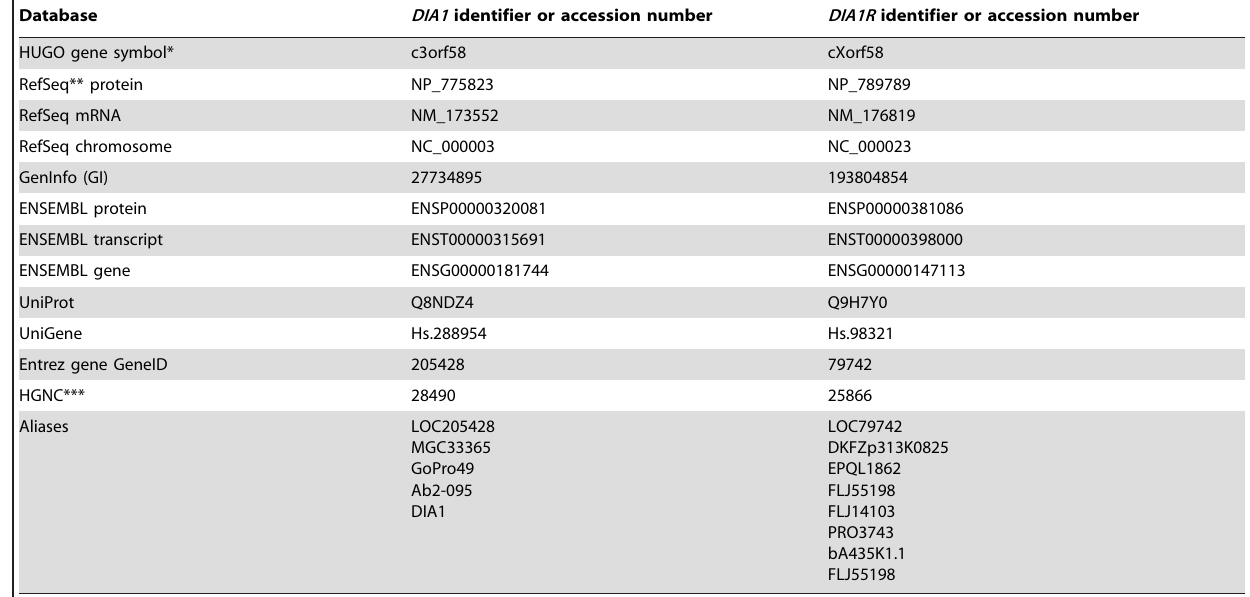
Table 1. Accession numbers and identifiers for human DIA1 and DIA1R